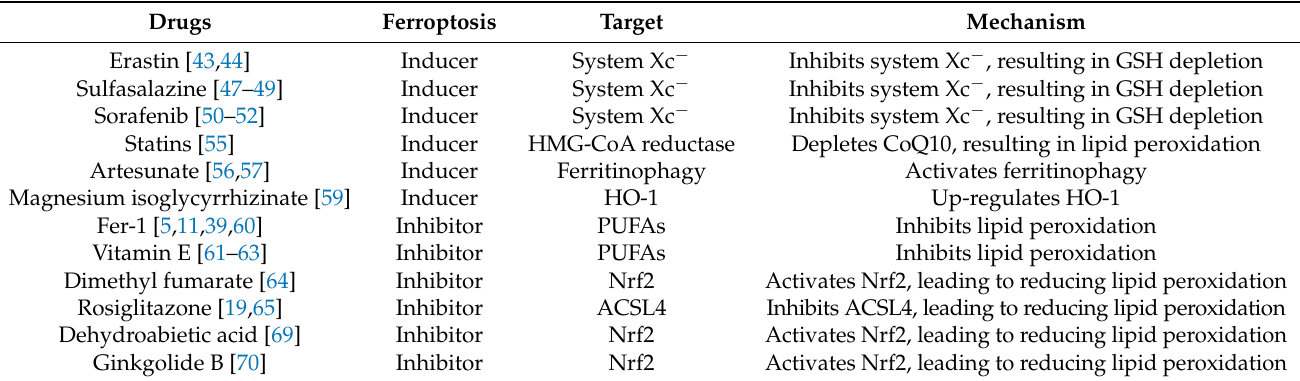
Table 1. Drugs targeting ferroptosis in liver